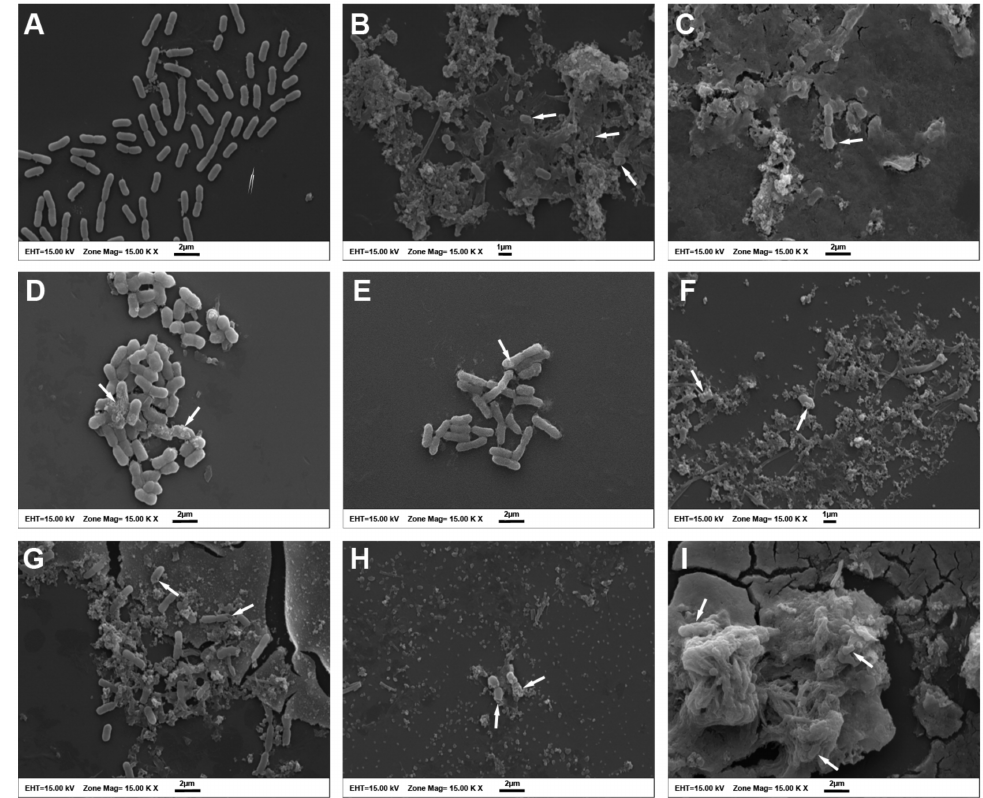
Figure 3. Scanning electron micrographs of ColR-Ab4 strain: ( A ) untreated; ( B ) treated with COL at MIC value; ( C ) treated with COL at FIC value; ( D ) treated with AMK at MIC value; ( E ) treated with AMK at FIC value; ( F ) treated with QUE at MIC value; ( G ) treated with QUE at FIC value; ( H ) treated with QUE + COL at the synergistic concentration; ( I ) treated with QUE + AMK at the synergistic concentration. White arrows indicate damaged bacterial cells. Scale bars, 2 µ m in ( A , C , D , E , G – I ), and 1 µ m in ( B , F